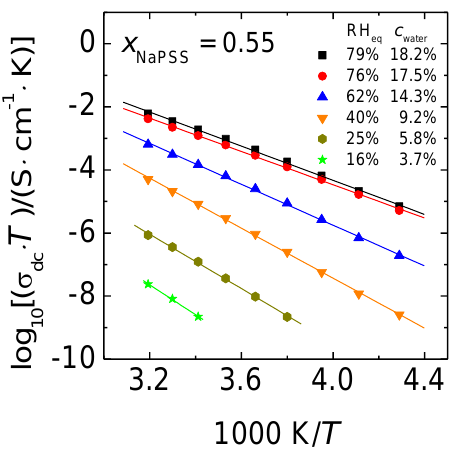
Figure 6. Arrhenius representations of data sets of 0.55 NaPSS · 0.45 PDADMAC PEC determined at different water contents. The error of the data is within symbol size.